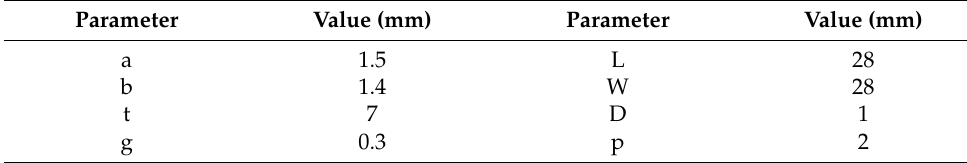
Figure 3. HFSS simulated results of: ( a ) width, a, of the slot antenna, ( b ) gap, b, of CSRR, ( c ) length, t, of the slot antenna, and ( d ) distance, h, between the waveguide antenna and the sensor. The final parameters of the sensor that satisfied the WiMAX band are listed in Table 1. Table 1. The detailed parameters of the designed